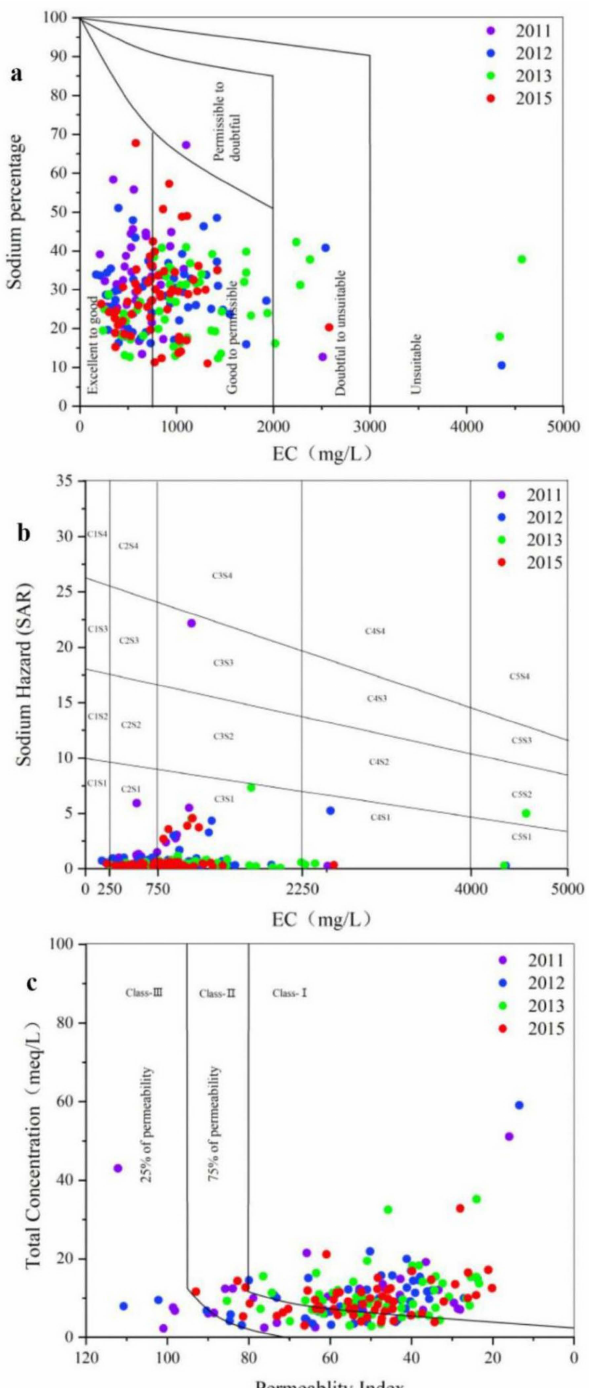
Figure 5. Irrigations hazards classifications by sodium percentage ( a ), sodium adsorption ratio, SAR ( b ), and permeability index, PI ( c